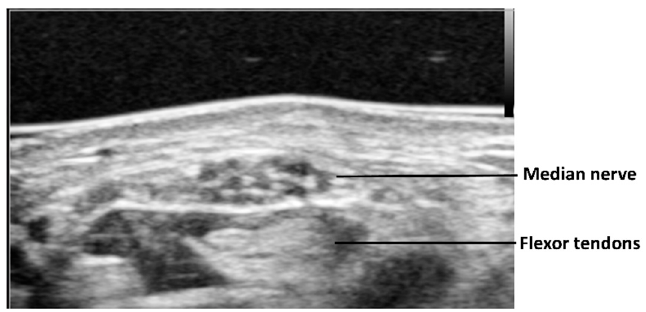
Figure 1. A typical ultrasound image of median nerve at proximal carpal tunnel.